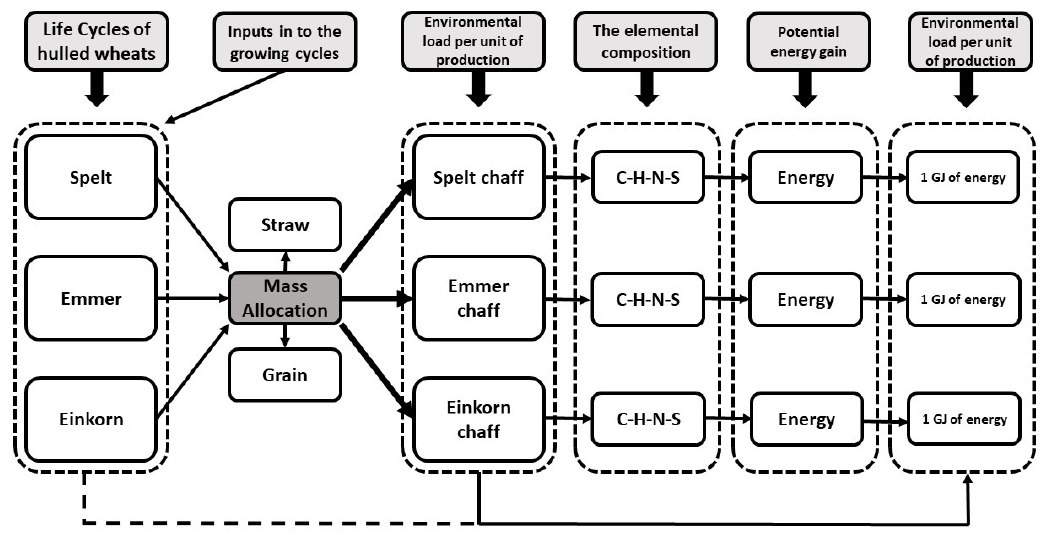
Figure 1. Workflow scheme.